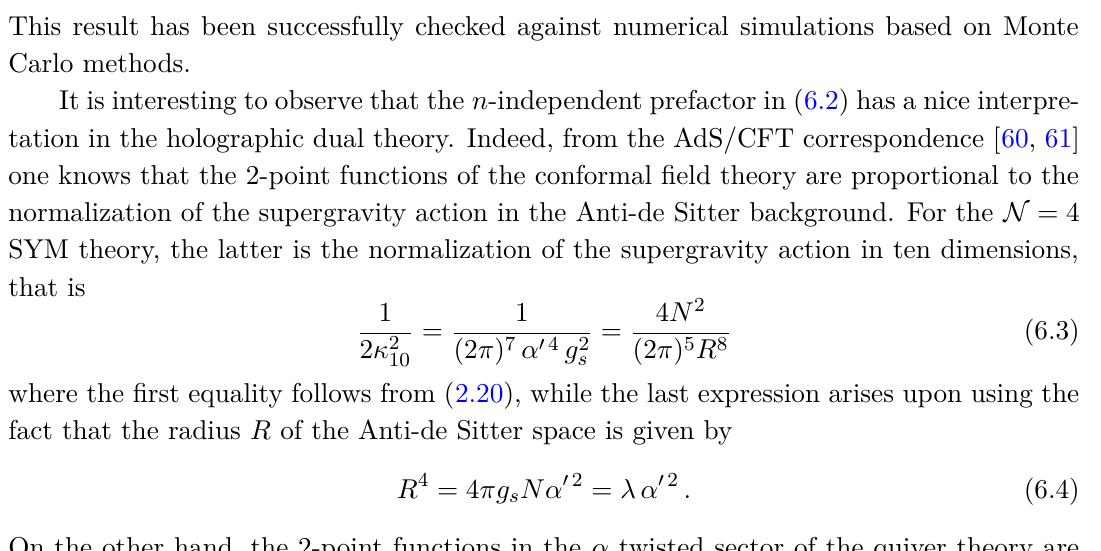
JHEP10(2021)161